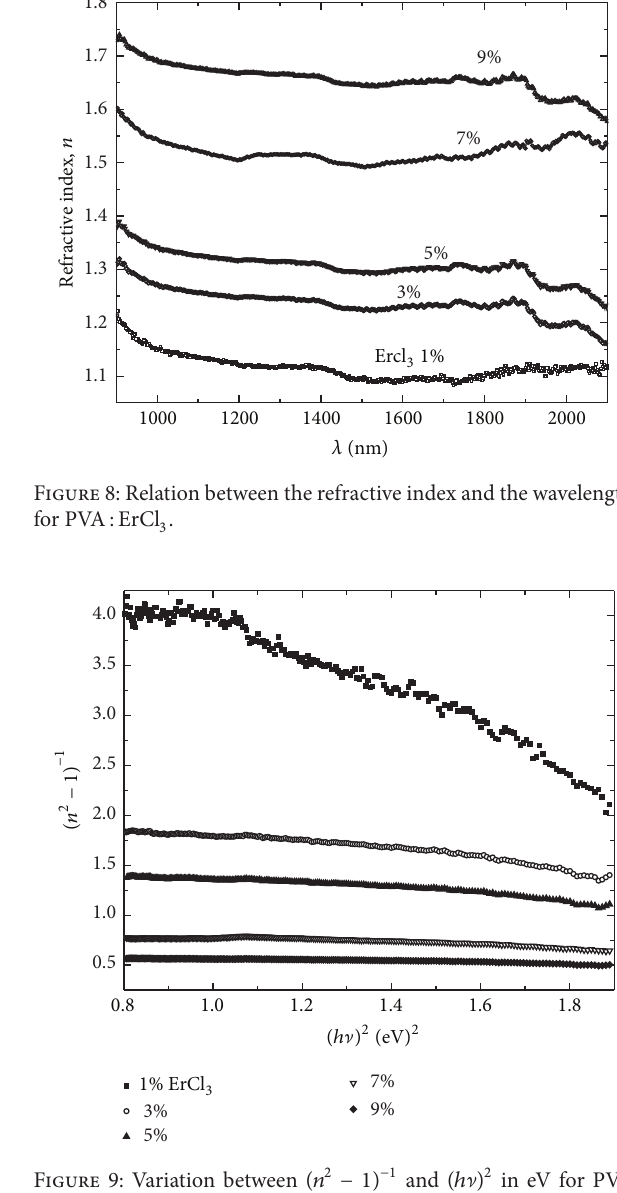
Figure 9: Variation between ( 𝑛 2 − 1 ) −1 and ( ℎ ] ) 2 in eV for PVA doped with different ErCl 3